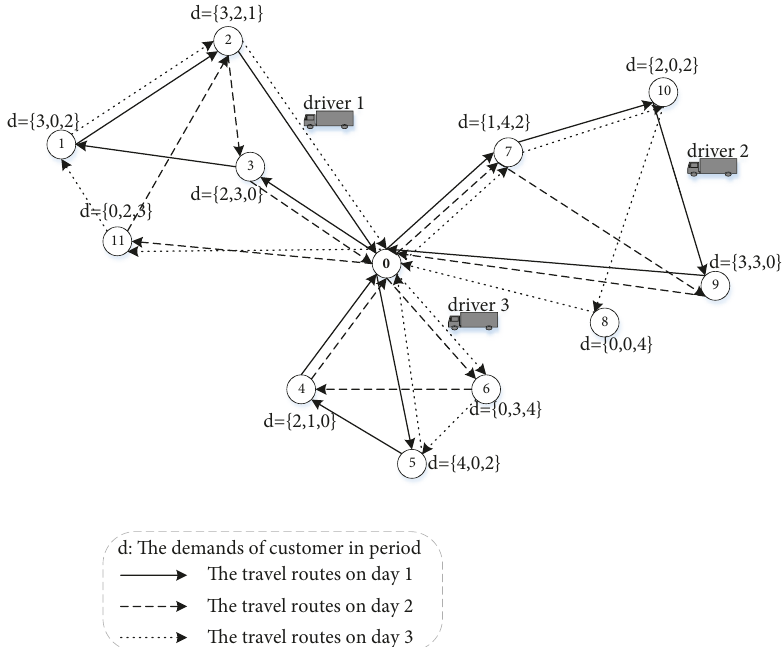
Figure 2: The operated routes by drivers in